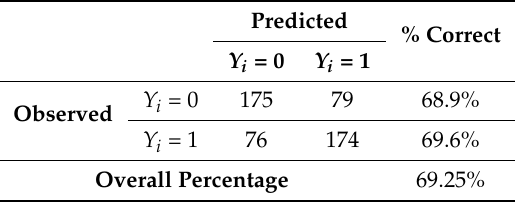
Table 9. Prediction capabilities of the final Logit